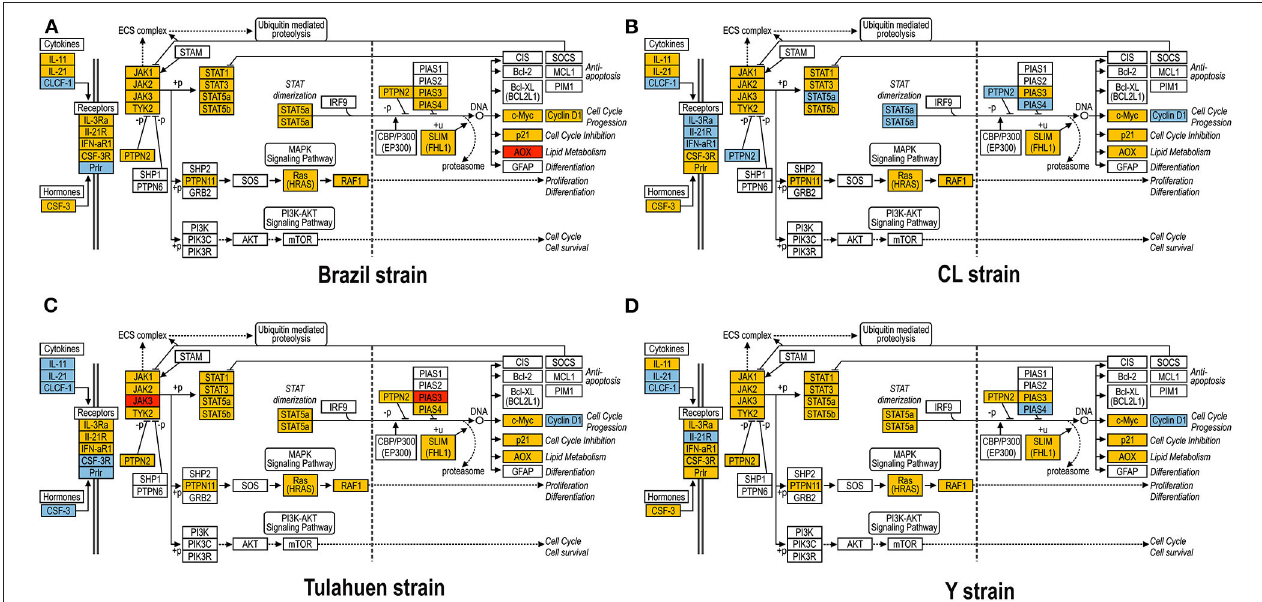
FIGURE 2 | Kyoto Encyclopedia of Genes and Genomes (KEGG) analysis of the JAK/STAT Pathway in Trypanosoma cruzi -infected myoblasts. The JAK/STAT Pathway obtained from the KEGG platform was used as template to highlight the effect of Brazil (A) , CL (B) , Tulahuen (C) , and Y (D) strain in L6E9 rat myoblasts. Blue boxes indicate significant upregulation ( > 1.5-fold), and red boxes indicate significant downregulation ( < -1.5-fold). Yellow boxes indicate genes that showed no significant alteration in infected vs. control cultures, whereas white boxes indicate genes that were absent in the analysis (i.e., those that for any reason did not match the exclusion criteria; e.g., a positive signal in all four biological replicas of each group). Extracellular ligands such as IL-6 family of cytokines bind to membrane receptors, including IL-3R and IL-21R, which in turn activate members of the JAK/STAT pathway or, alternatively, of the MAPK signaling pathway. STATs translocate to cell nucleus and activate transcription of genes that can activate cell cycle, apoptosis, or cell differentiation.